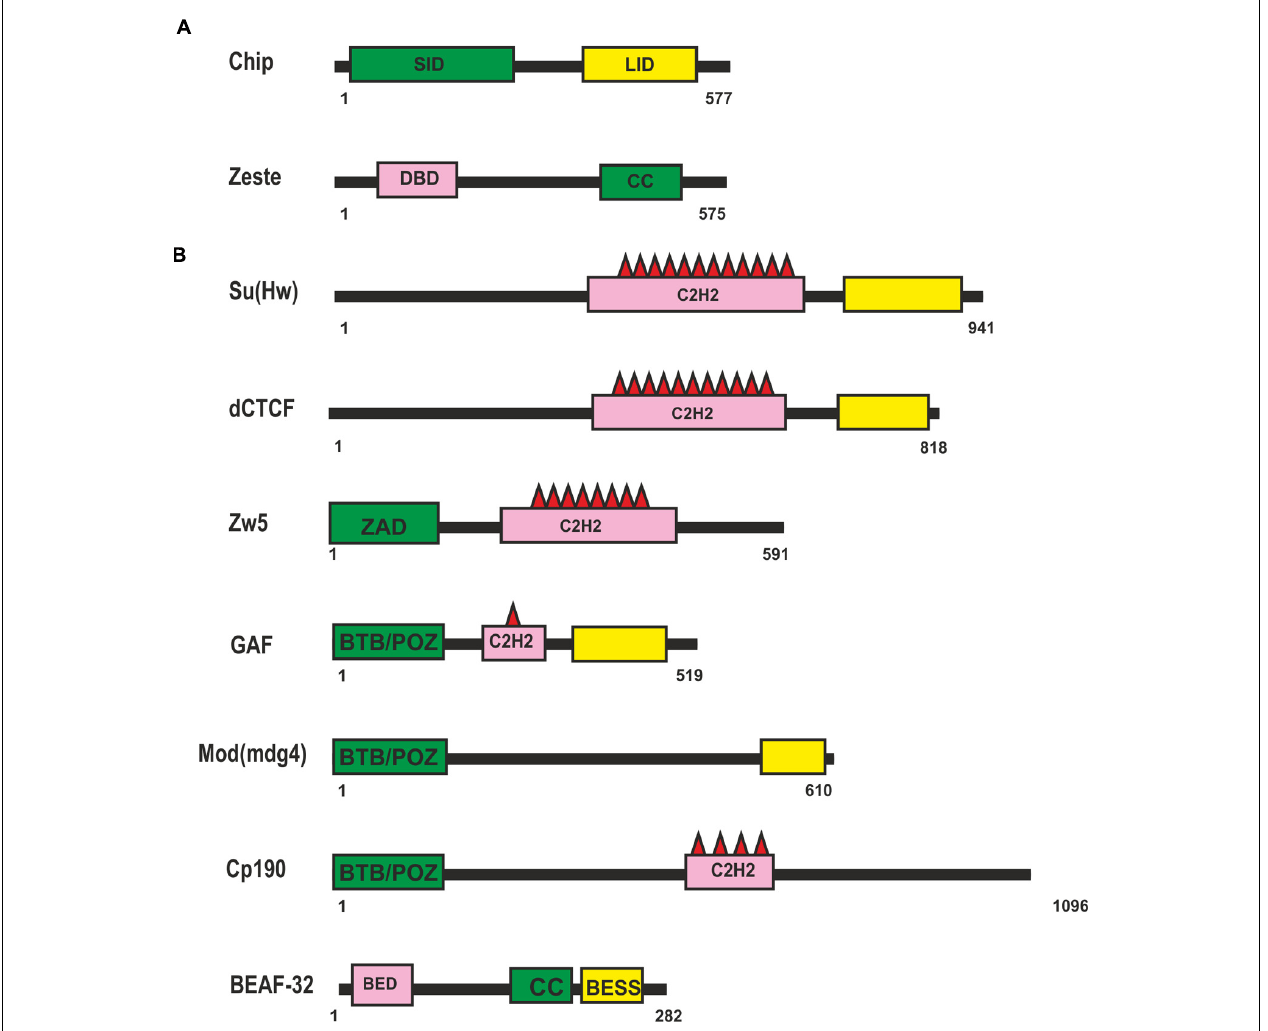
self-interaction domain (SID), LIM-interaction domain (LID), DNA binding domain (DBD), coiled-coil domain (CC), Zinc-fingers of C2H2 type (C2H2), Zinc-finger Associated Domain (ZAD), BTB/POZ domain, BED-type (BEAF and DREF) zinc finger domain (BED), BEAF, Su(var)3-7, and Stonewall domain